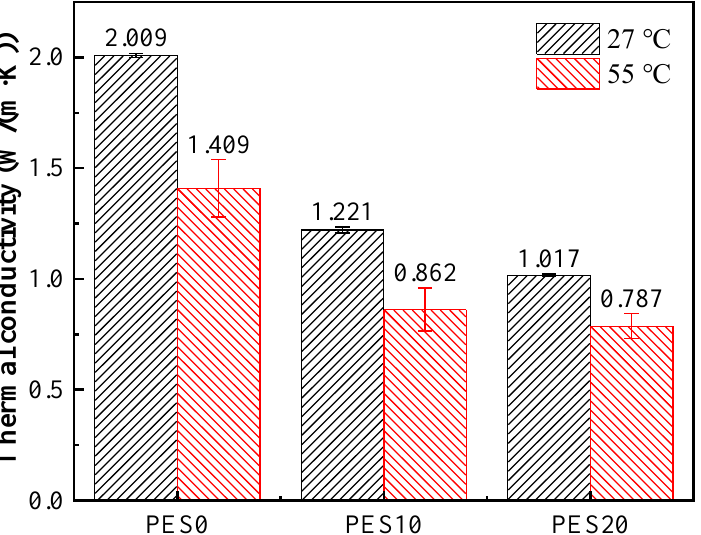
Figure 10. The thermal conductivities of samples with different SBS concentrations at 27 and 55 °C . The error bars are the standard deviation of the measurements (n = 3).